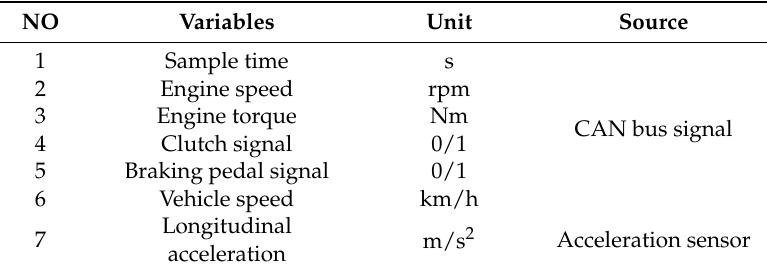
Table 3. Channel of measure variables.